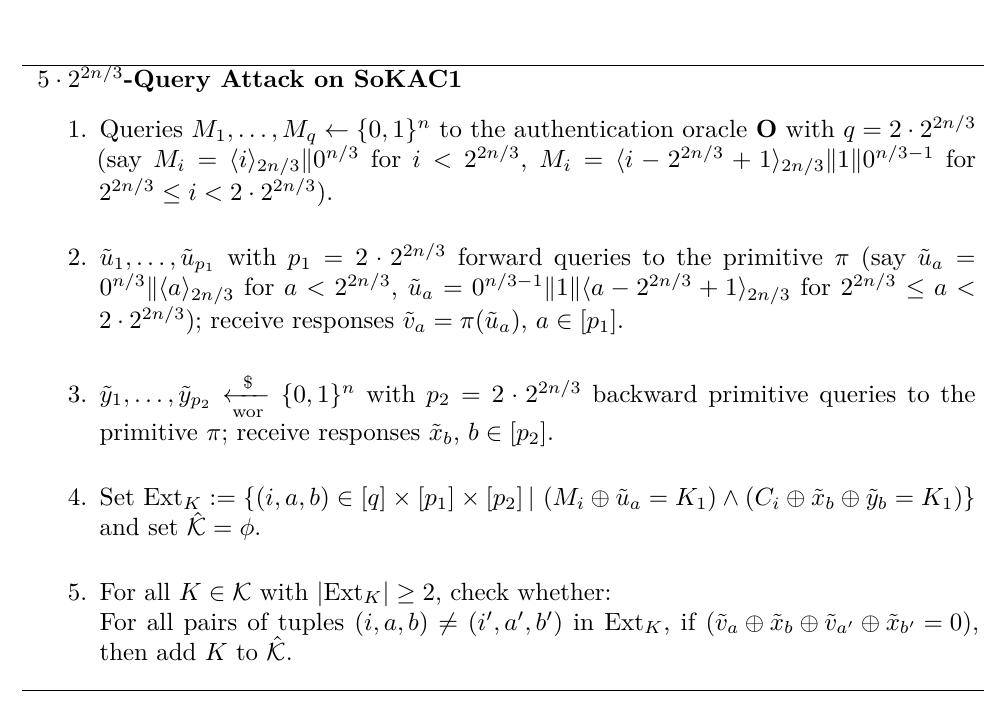
Figure 3: Interaction of the adversary with ( O , π ), where O is either the random oracle or the and the primitive π real construction oracle SoKAC1 π K